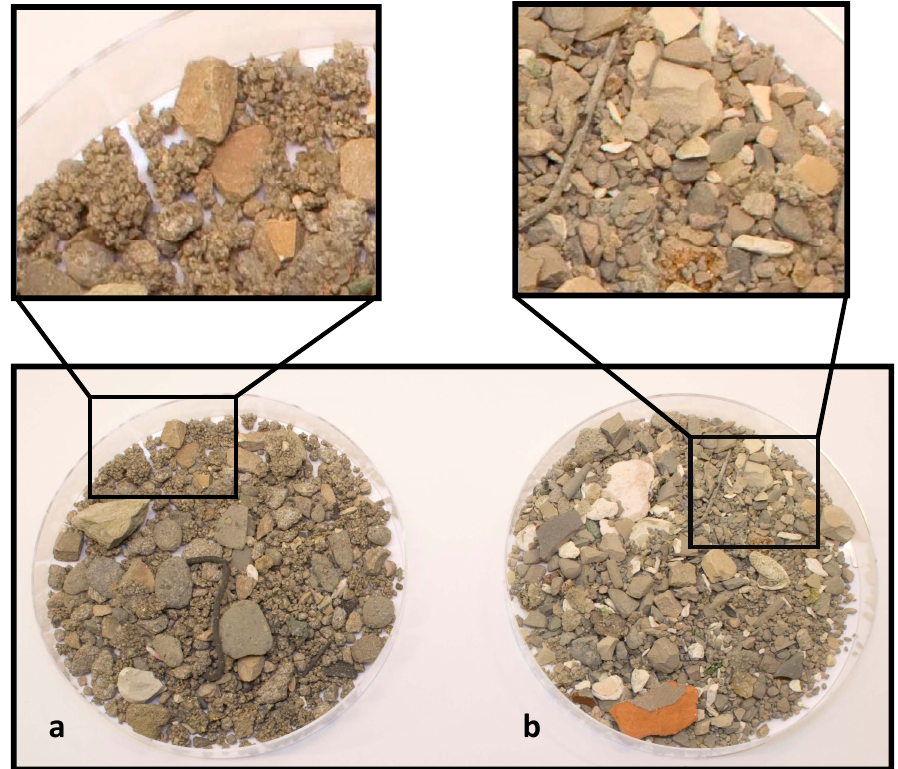
Figure 12. Bed ash samples: ( a ) Ref case, ( b ) AW